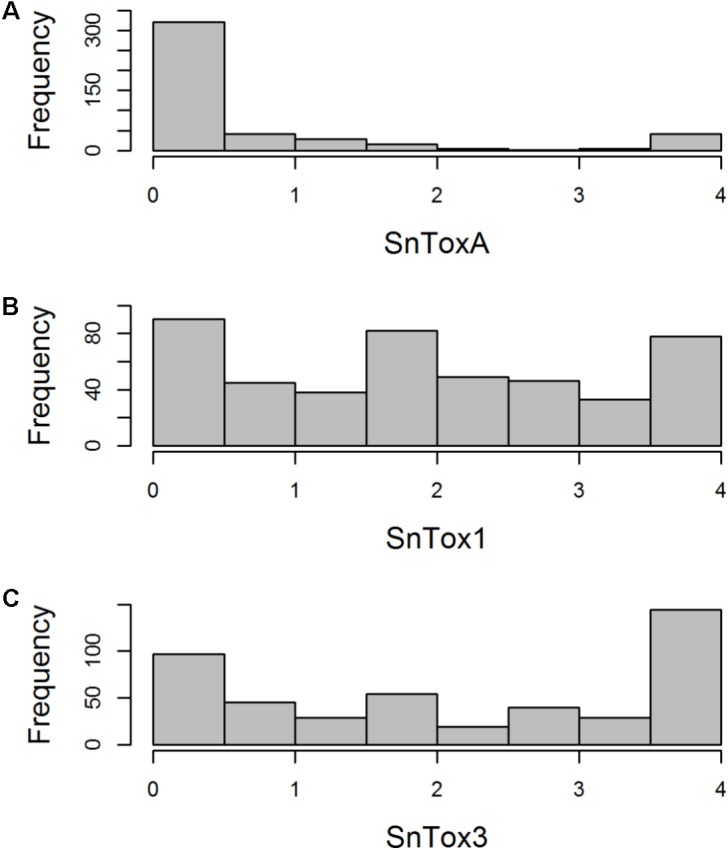
Histogram of host sensitivity to P. nodorum effectors (A) SnToxA, (B) SnTox1, and (C) SnTox3 in the AM panel of 480 northwest European wheat varieties. Sensitivity score (0 = insensitive, 4 = sensitive) for each accession represents a mean of four biological replicates.